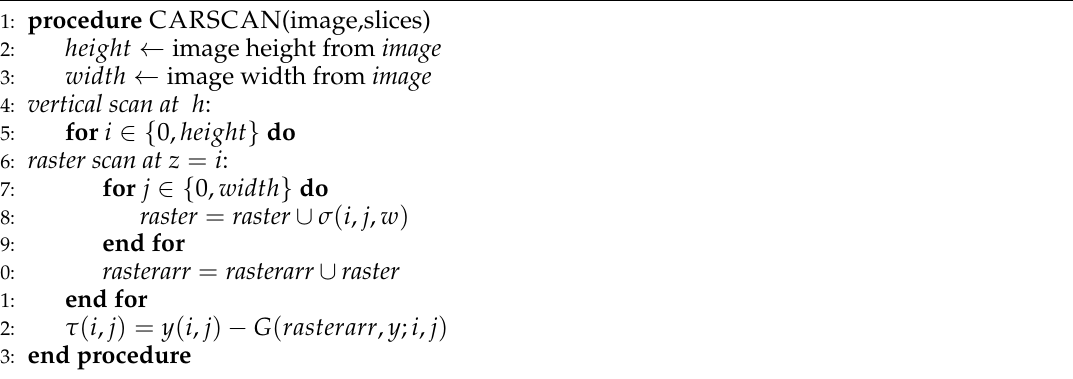
Algorithm 1 Pseudo code description of a Cartesian soil field extraction. Input = discretized horizontal image slices v 0 . Output = σ ( x , z ) and τ ( x , z )